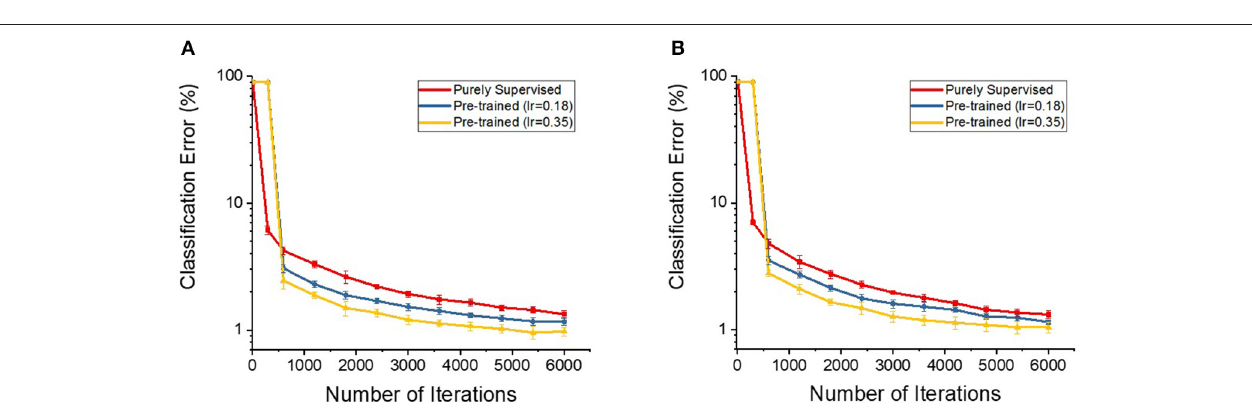
FIGURE 7 | The classification accuracies (in log scale) on the deep multi-layer convolutional spiking neural networks of pre-trained and supervised model starting from (A) Lee initialization (B) Glorot initialization.